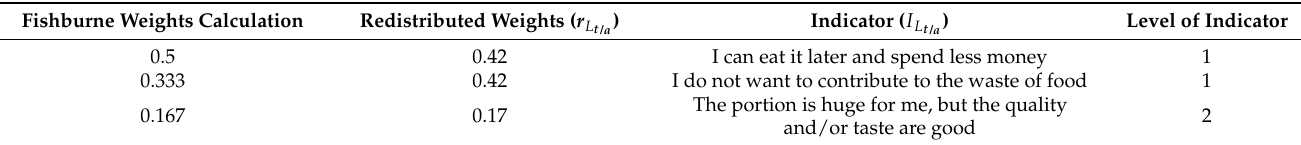
Table 5. Reasoning indicators for taking away food leftovers.